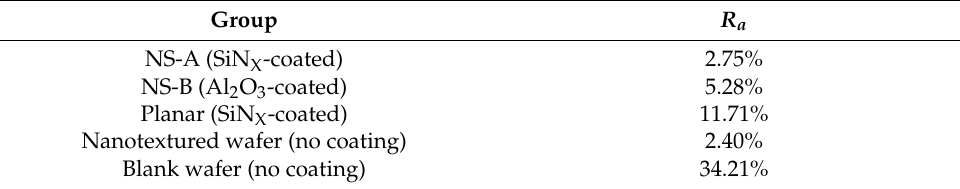
Figure 3. The reflectance of silicon nanotextured solar cells with passivation layers of 80 nm SiN X and 100 nm Al 2 O 3 . For comparison, the reflectance of a blank wafer, as well as that of a planar cell coated with 80 nm SiN X and a silicon nanotextured wafer without deposition, is also plotted. Table 1. The weighted average reflectance ( R a ) of samples and reference wafers.